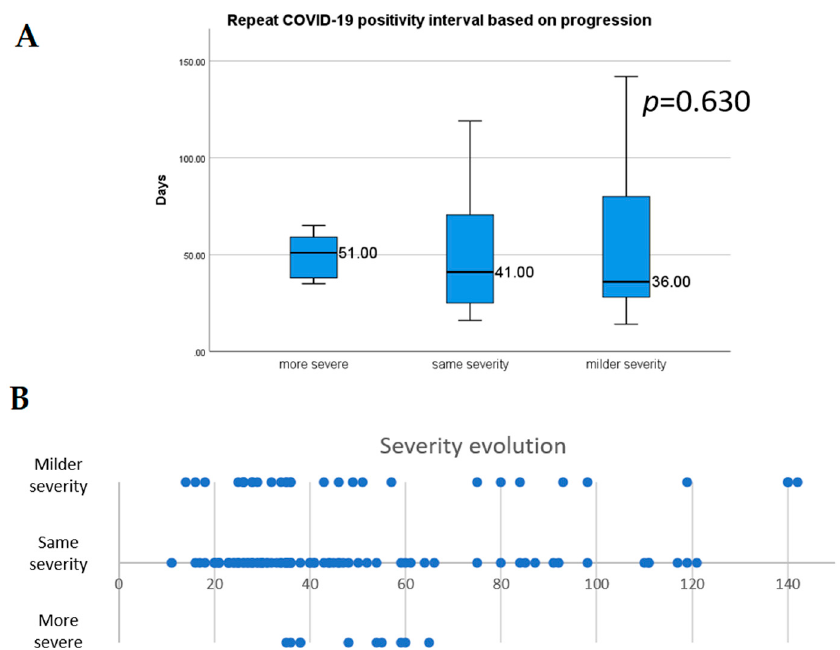
Figure 5. Median repeated positivity length based on progression ( A ), and distribution of the progression of the second episode ( B ). Error bars represent 1.5 times the interquartile range.